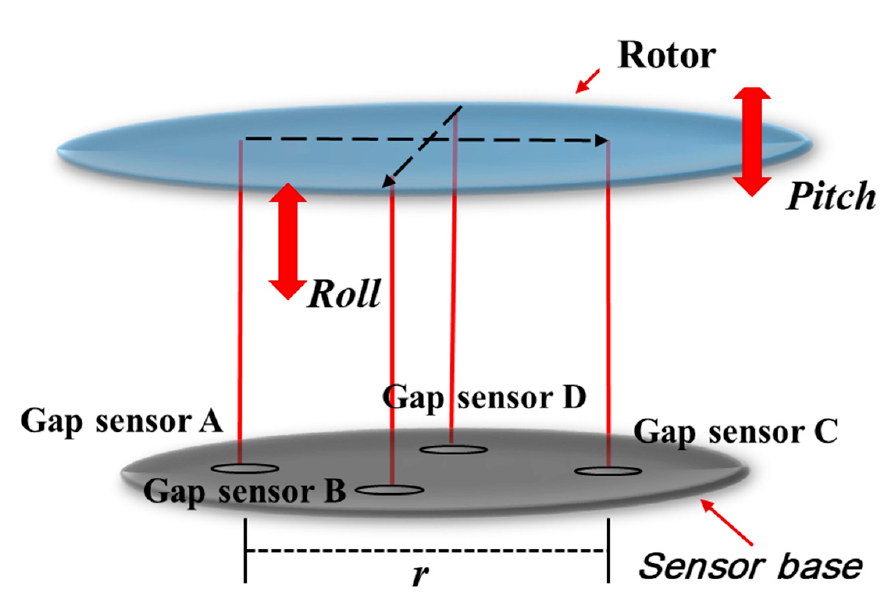
Figure 5. Conceptual diagram of Magnetic levitation system with non-contact position sensors.